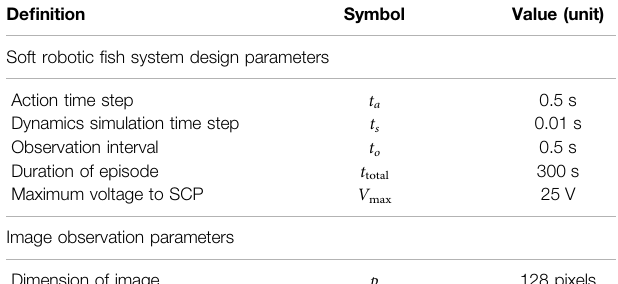
TABLE 1 | Simulation